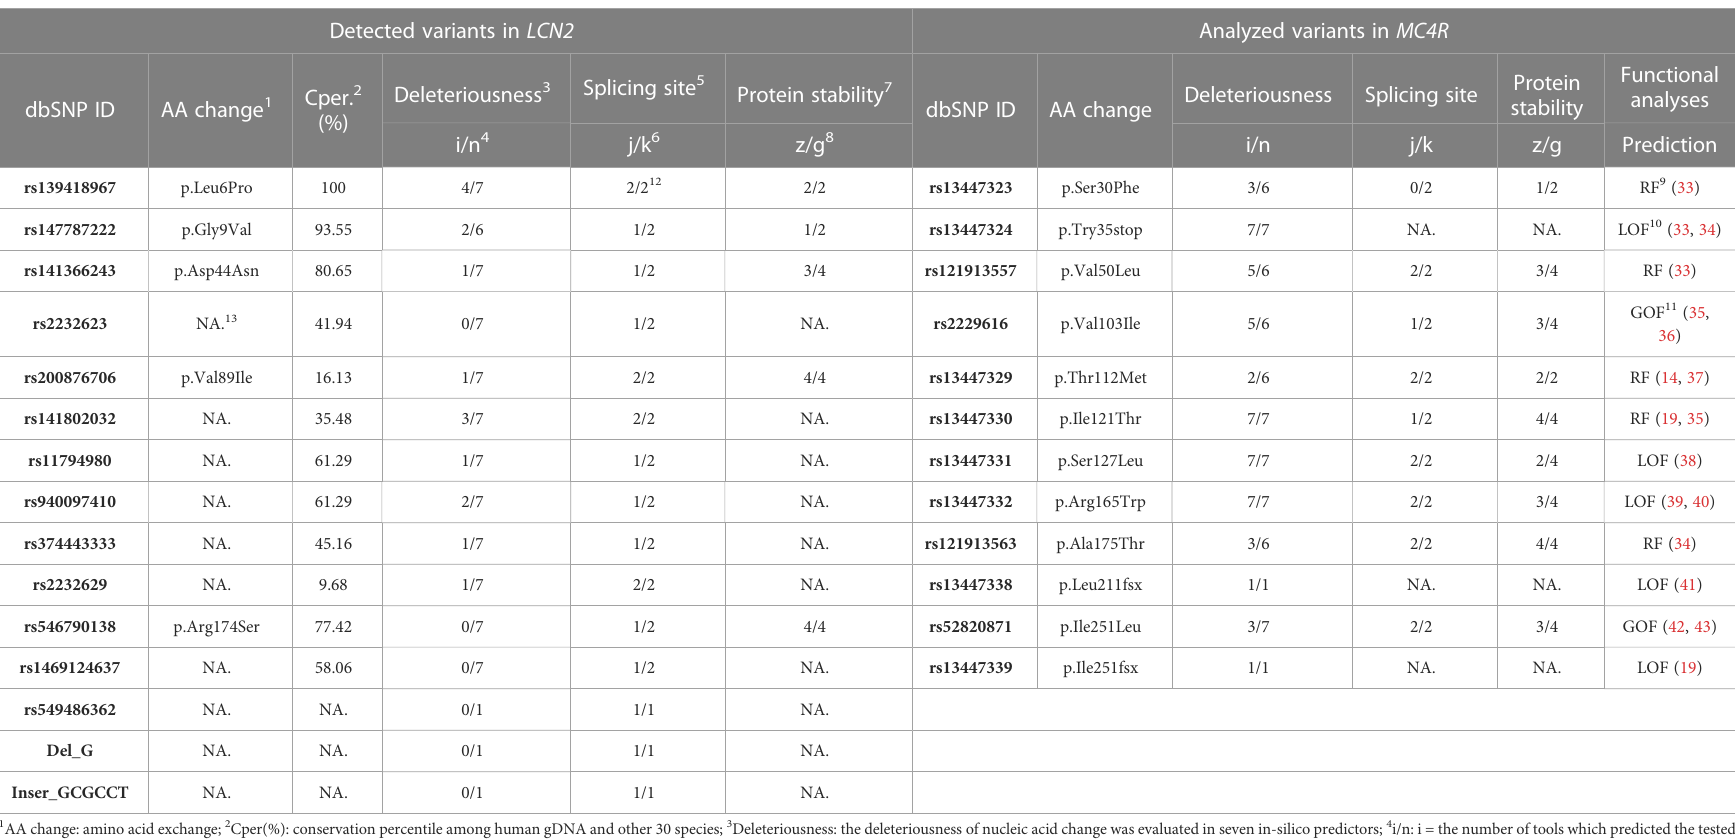
TABLE 3 In-silico analyses for detected variants in LCN2 and those MC4R variants subjected to ELISA